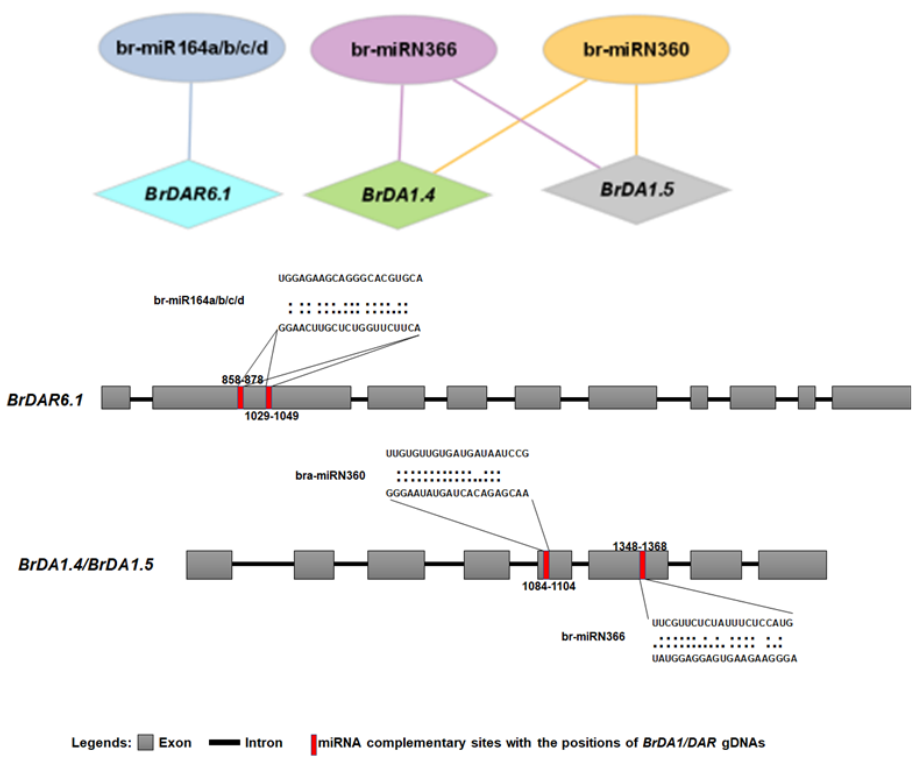
Figure 6. The miRNA targeting sites in BrDA1 & DAR genes ( BrDAR6.1 , BrDA1.5, and BrDA1.4 ).